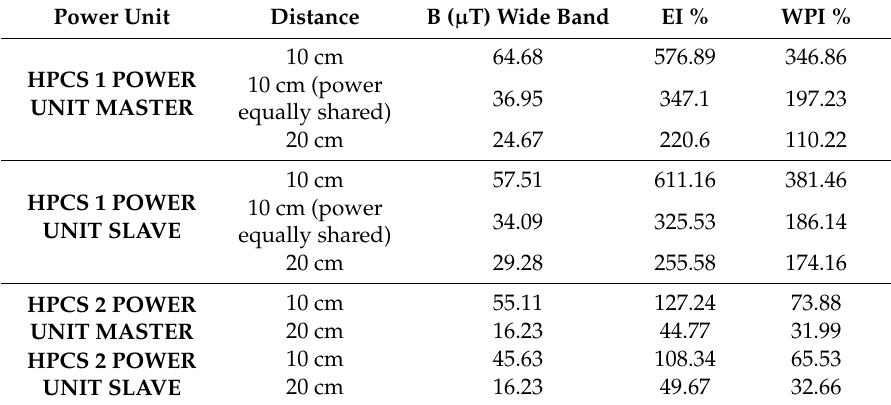
Table 7. Characterization of the points of maximum emissions for HPCSs 1 and 2.